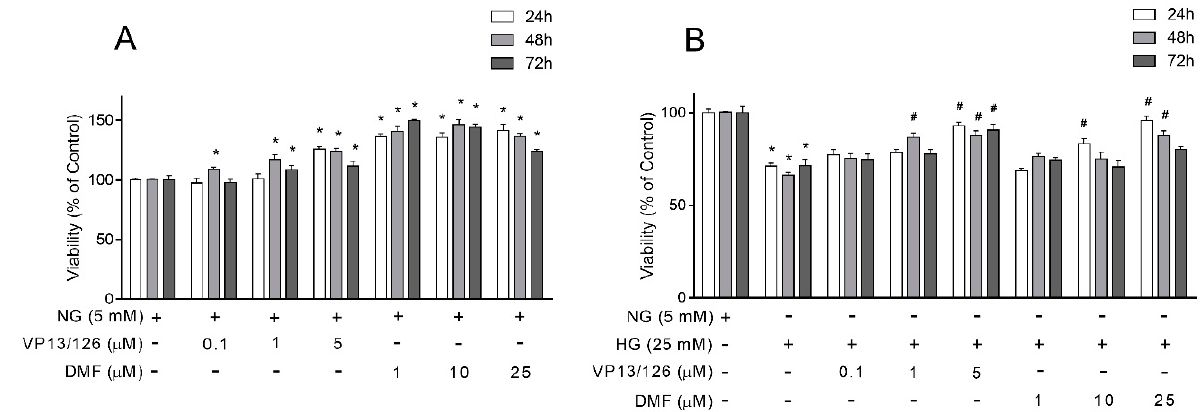
Figure 2. Effects of VP13/126 and DMF on cell viability of SIRC stimulated by HG. (A): MTT assays were carried out in cells treated for 24, 48 and 72 h with normal glucose (5 mM) with or without increasing amounts of VP13/126 (0.1, 1 and 5 µ M) or DMF (1, 10 and 25 µ M). (B): cells treated with HG (25 mM) with or without increasing amounts of VP13/126 (0.1, 1 and 5 µ M) or DMF (1, 10 and 25 µ M). Values are expressed as a mean ± SEM of three independent experiments, each run in triplicate. * p < 0.05 vs. NG; # p < 0.05 vs. HG alone in the respective conditions. Two-way ANOVA, followed by Tukey’s test.